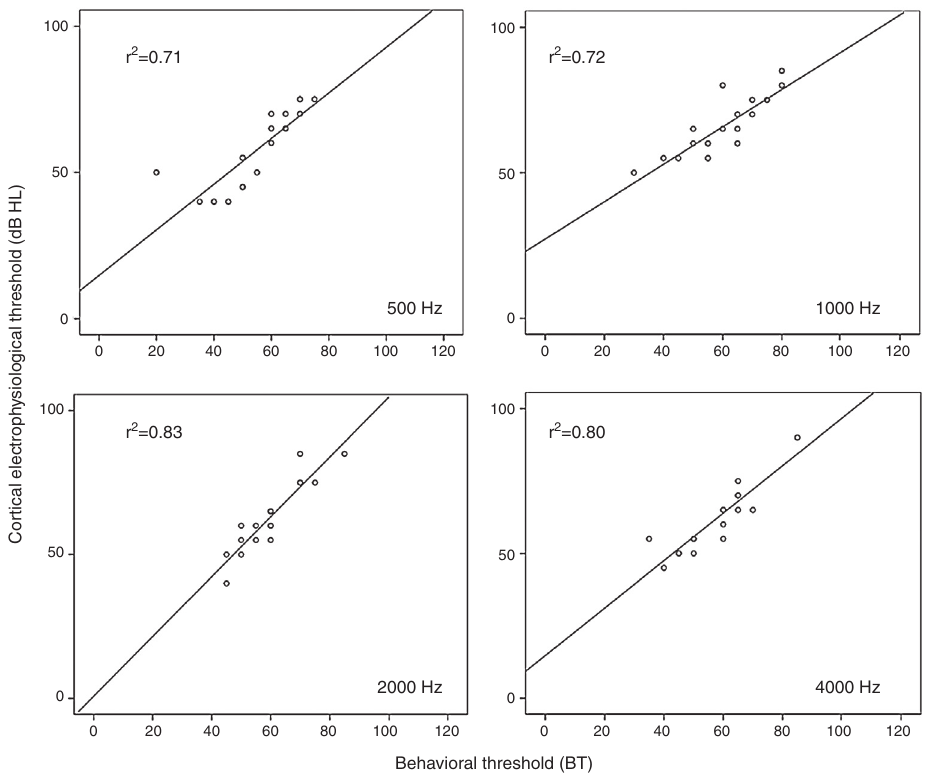
Linear scatter plots of the group with hearing loss. Behavioral threshold (BT) × cortical electrophysiological threshold (CET) to tone burst at 500, 1000, 2000, and 4000